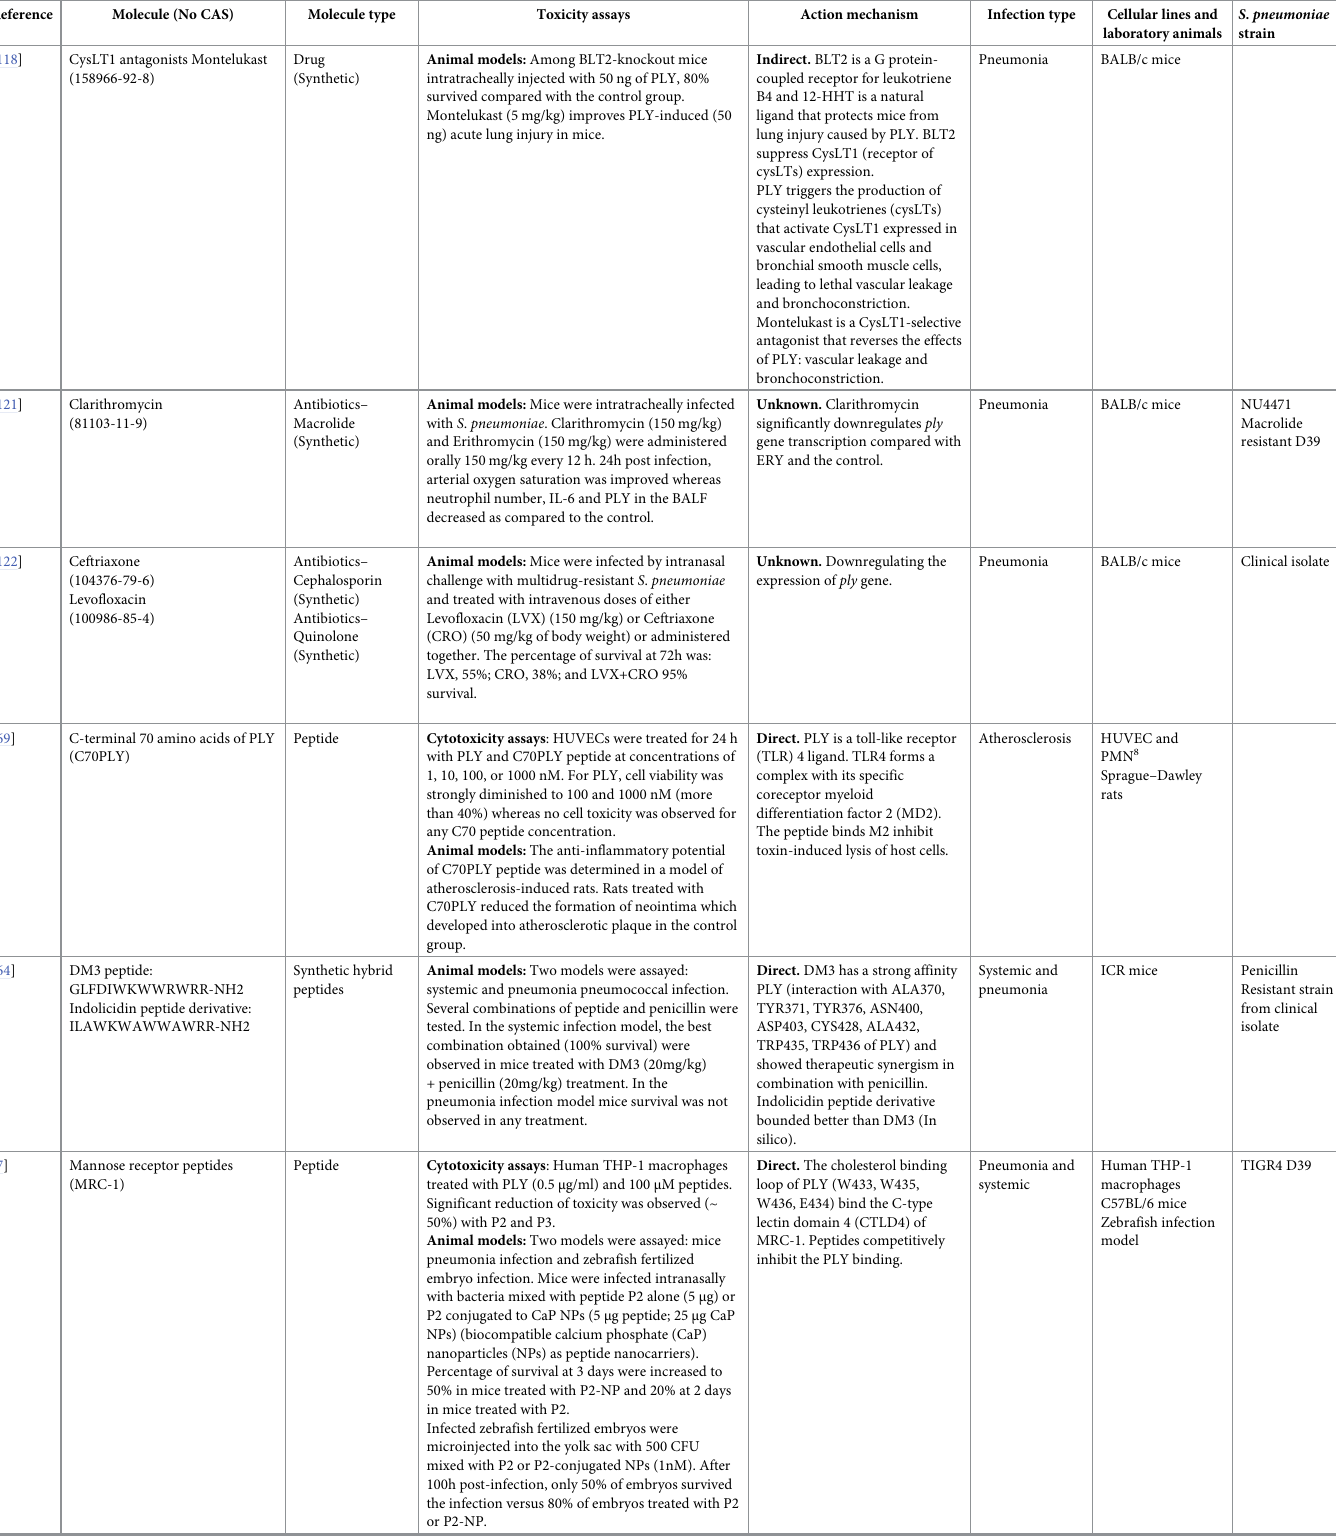
Synthetichybrid